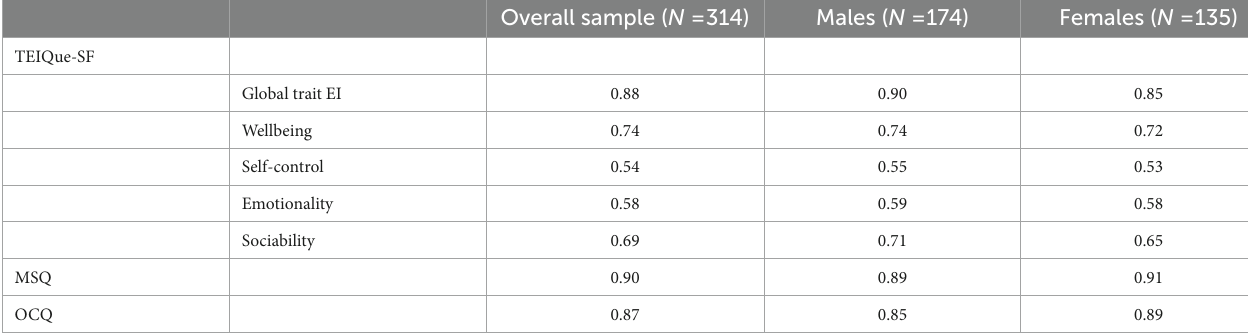
TABLE 3 Gender-based Cronbach’s α for key variables in the study.